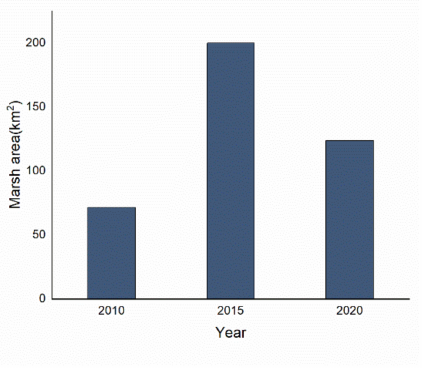
Figure 4. Changes in the area of marsh in the Xianghai Nature